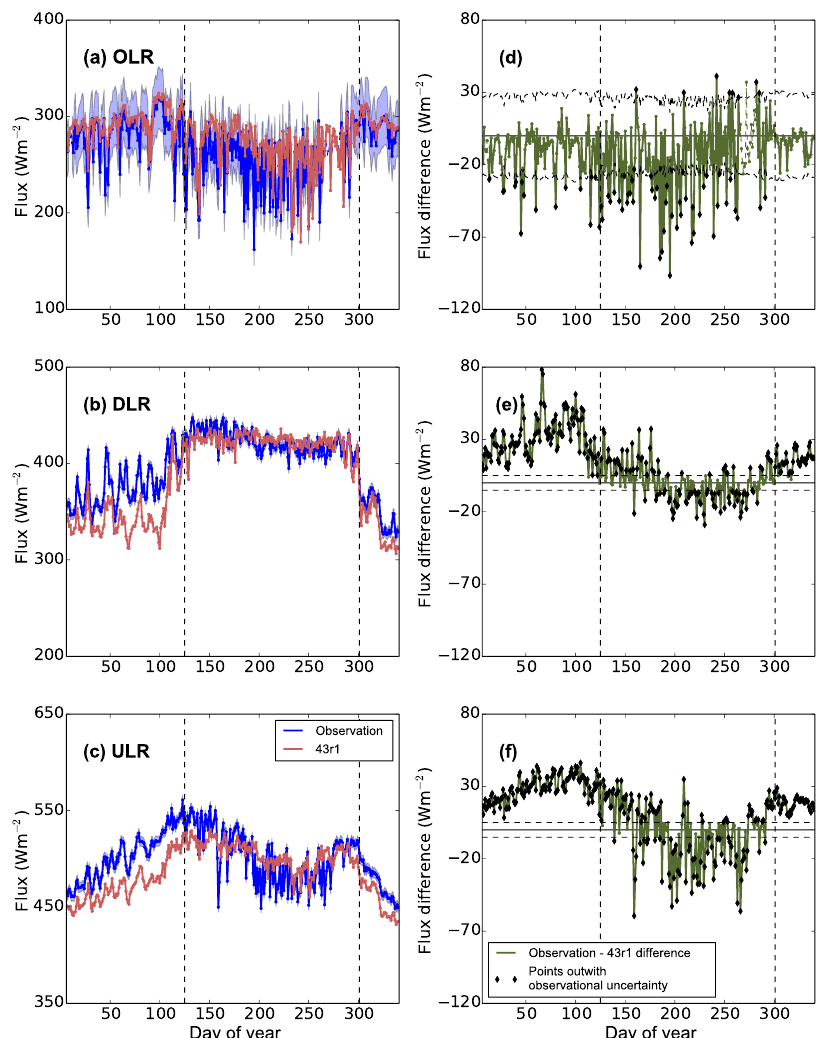
Figure 3. The same as Fig. 2 but for longwave fluxes. Plots show observed and 43r1 (a) TOA outgoing longwave; (b) surface downwelling longwave; (c) surface upwelling longwave radiation fluxes; and the observation–43r1 difference of these same fluxes in plots (d) – (f) , respec-